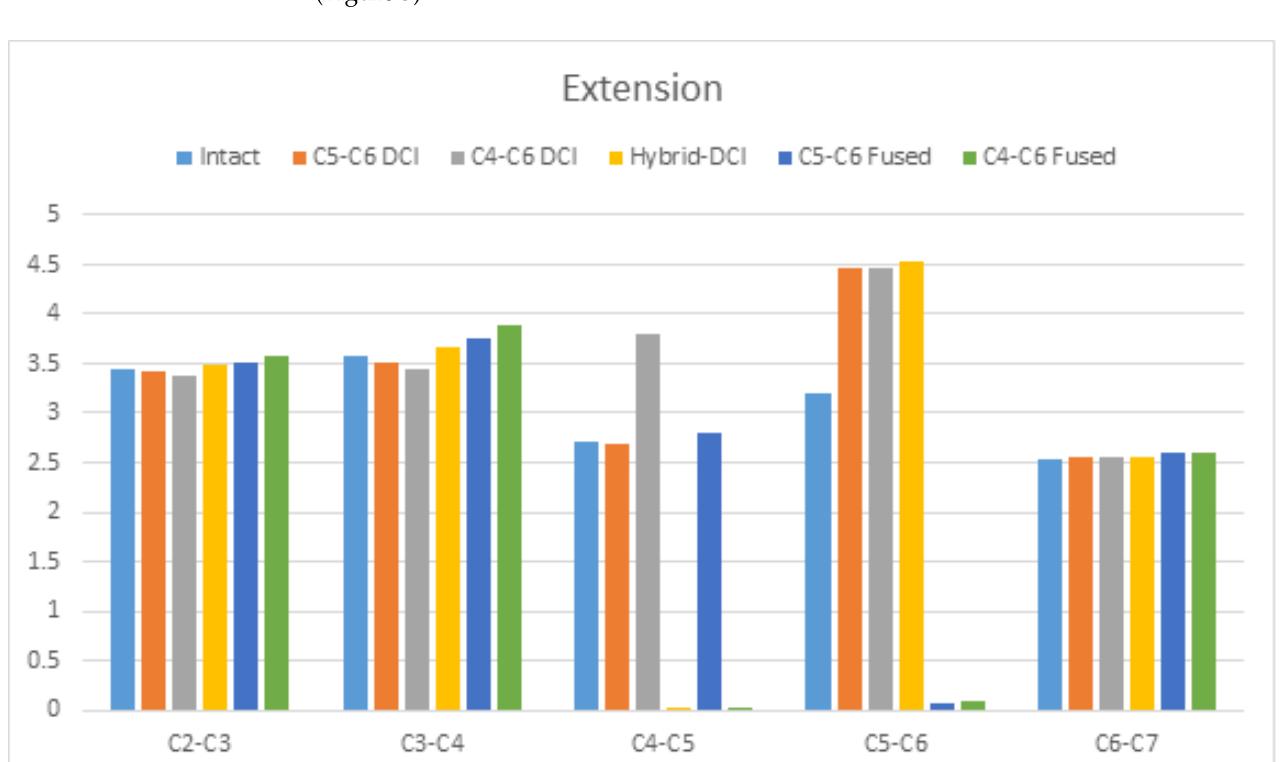
Figure 5. The comparison of ROMs during extension among the C5–C6 DCI, C4–C6 DCI, hybrid DCI, C5–C6-fused, and C4–C6 fused models. The vertical axis shows ROMs in degrees. Under LB, the C4–C6 DCI model had 66.6% and 83.70% reductions in the ROM at the C4–C5 and C5–C6 segments, respectively, compared to the intact model. The